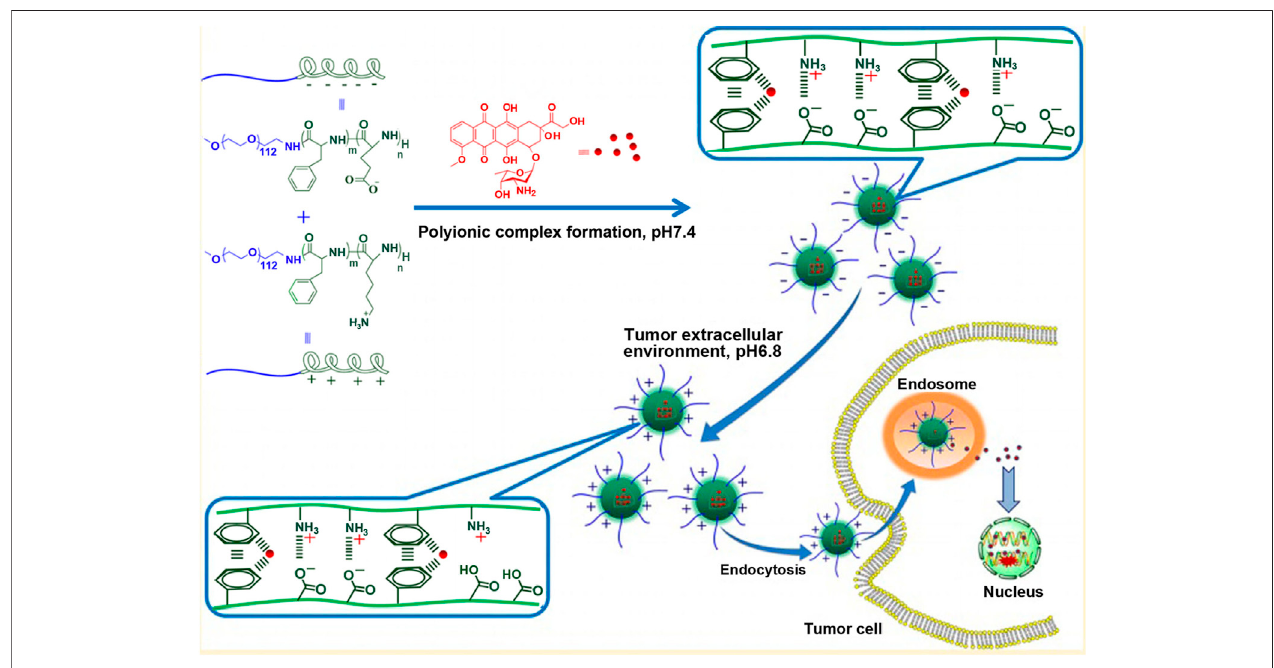
FIGURE 4 | Schematic illustration of charge-conversional behavior and endocytosis performance of polyion complex micelles (Lv et al., 2014).